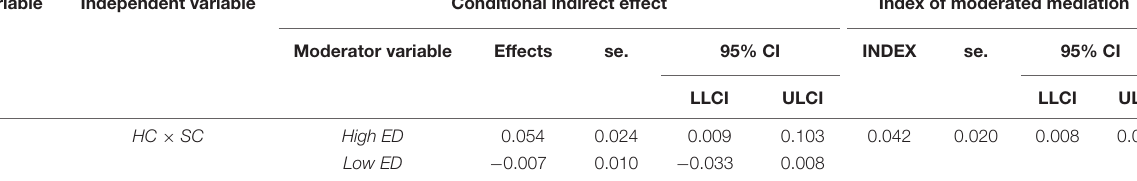
TABLE 5 | Bootstrapping of moderated mediation.